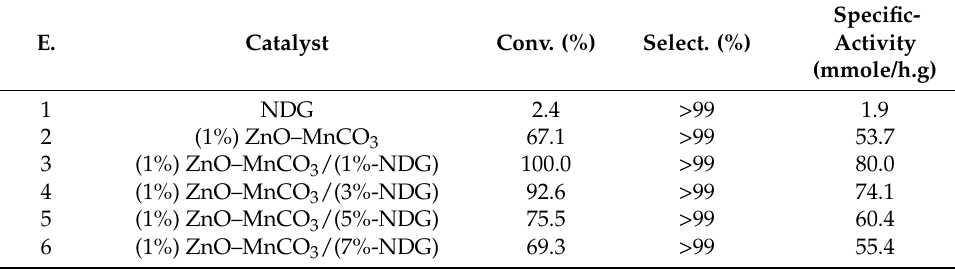
Table 2. Catalytic efficacies of several prepared catalysts.